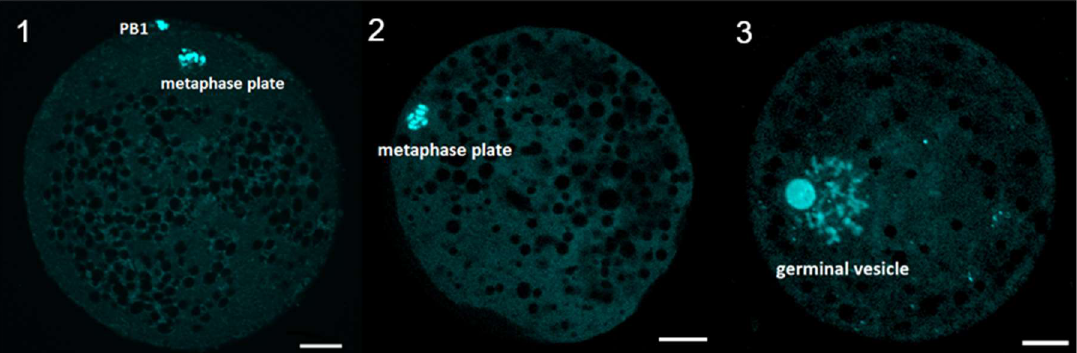
Figure 9. Evaluation of meiotic maturation after IVM. Representative images of porcine oocyte after in vitro maturation. ( 1 ) mature oocyte at metaphase of second meiotic division ( 2 ) immature oocyte at metaphase of first meiotic division ( 3 ) immature oocyte at GV stage (germinal vesicle). Oocytes were stained by DAPI. Scale bar represents 20 µm. PB1—first polar body.